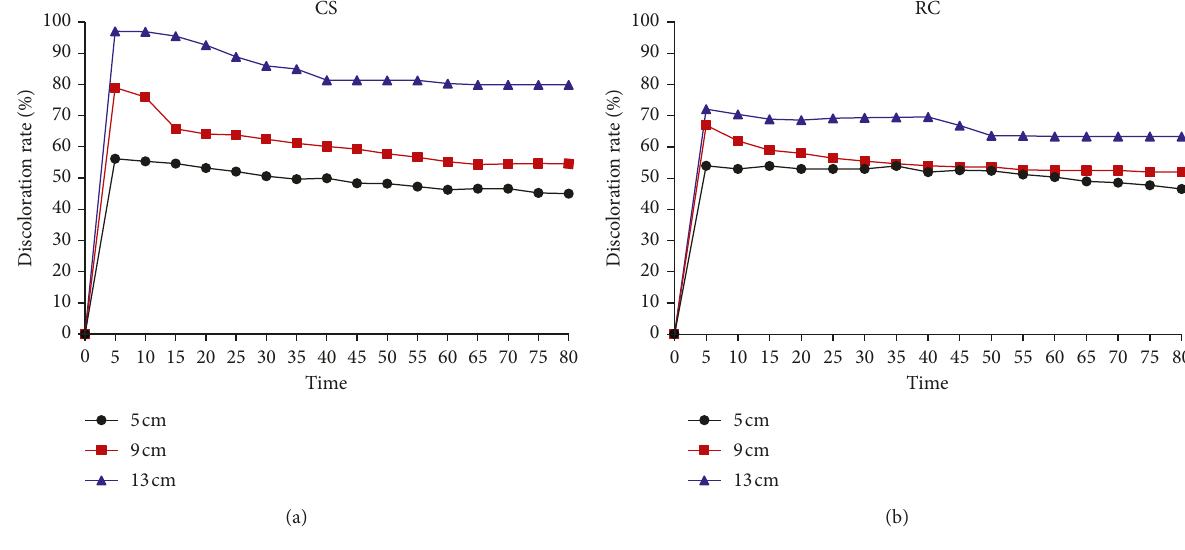
Figure 6: Effect of RS and CS bed height on discoloration rate. Table 1: Physicochemical characterization of the effluent before and after treatment by the two types of wood. Parameter WHO